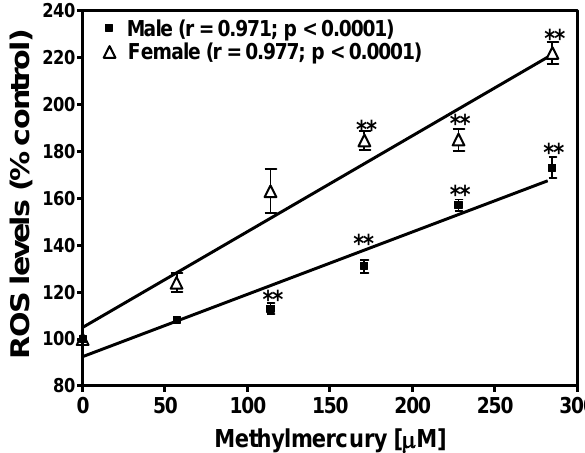
Figure 4. Effect of methylmercury in the diet on the levels of reactive oxygen species (ROS) in male and female flies. ROS values in control flies (no MeHg) were considered 100%. Data are presented as Mean ± S.E.M of four independent experiments. ** p < 0.01 as compared to controls, ANOVA (Dunnette). Linear regression analysis showed a significant correlation between methylmercury concentration in the diet and ROS levels in both male (r = 0.971) and female flies (r = 0.977).